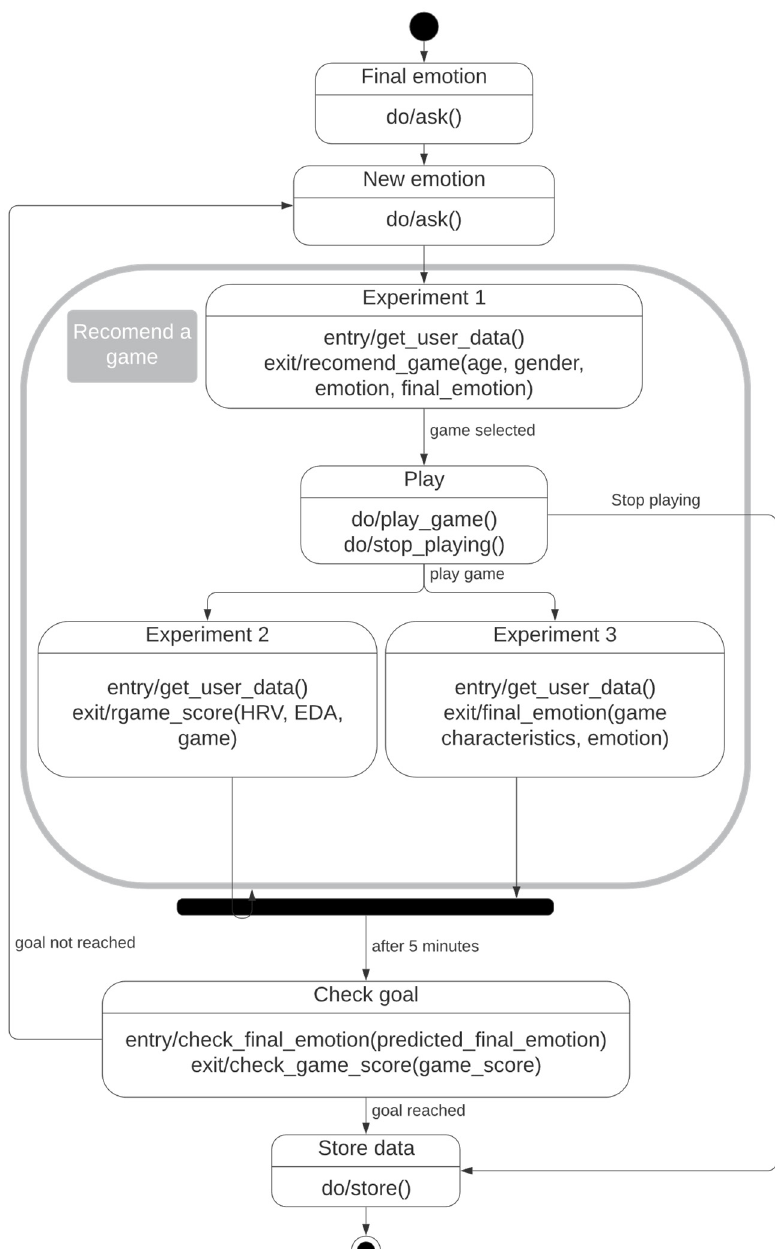
Figure 3. Recommender algorithm.